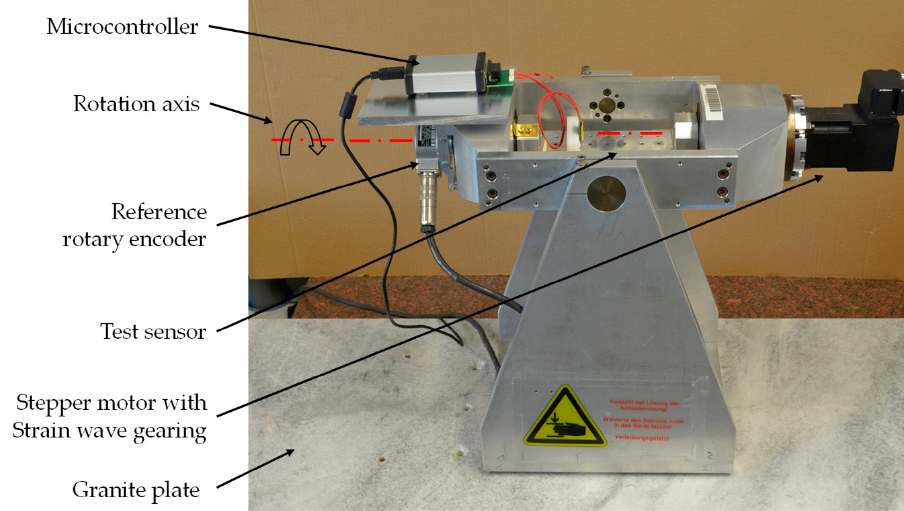
Figure 4. Test bench for measurement of characteristic curve.